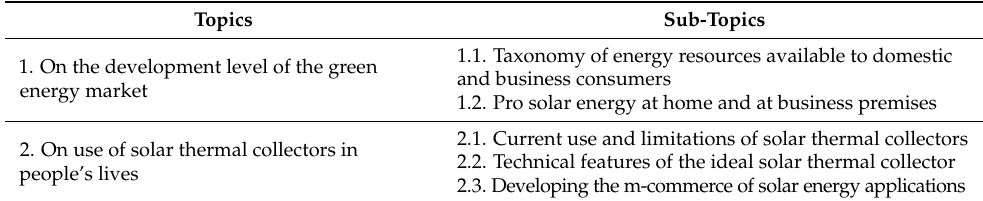
Table 1. Topics and sub-topics used within the focus group